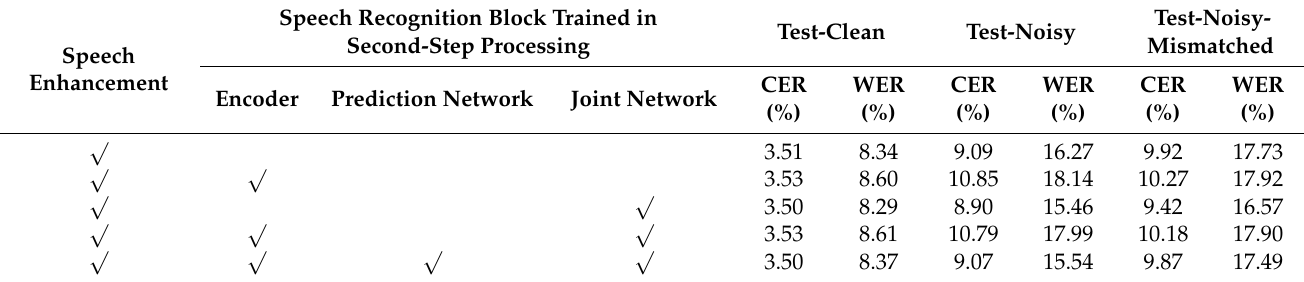
Table 3. Ablation study of the proposed two-step joint optimization approach applied to various com- binations of the processing blocks in the conformer-transducer speech recognition model, measured by average character error rate (CER) and word error rate (WER), where check symbol proposed two-step joint training approach being